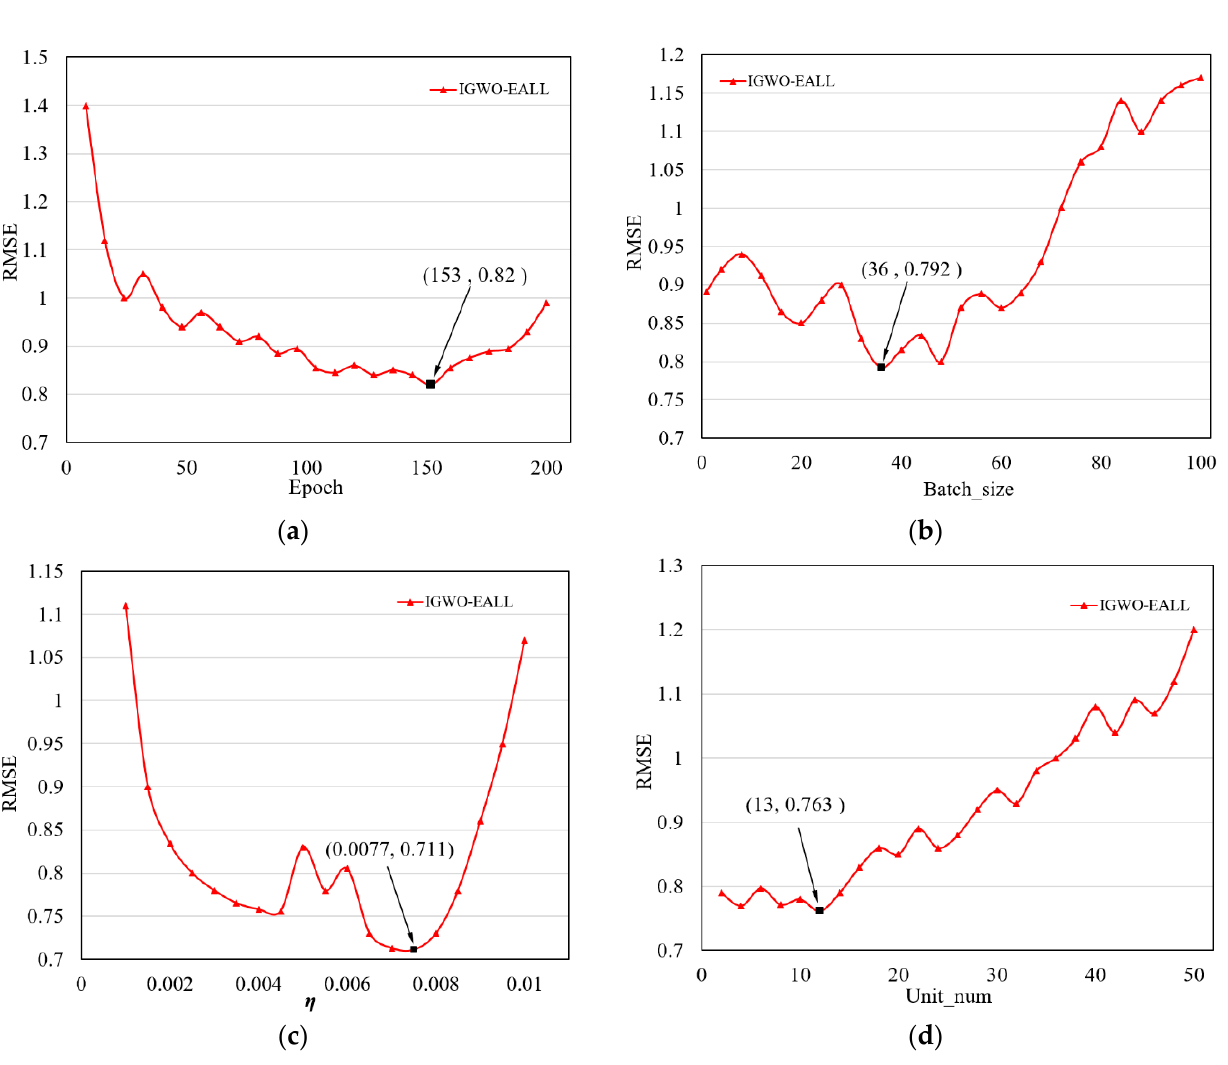
of 𝑒𝑝𝑜𝑐ℎ and RMSE; ( b ) variation curve of 𝑏𝑎𝑡𝑐ℎ_𝑠𝑖𝑧𝑒 and RMSE; ( c ) variation curve of 𝑛𝑢𝑚 of epoch and RMSE; ( b ) variation curve of batch _ size and RMSE; ( c ) variation curve of num and RMSE;